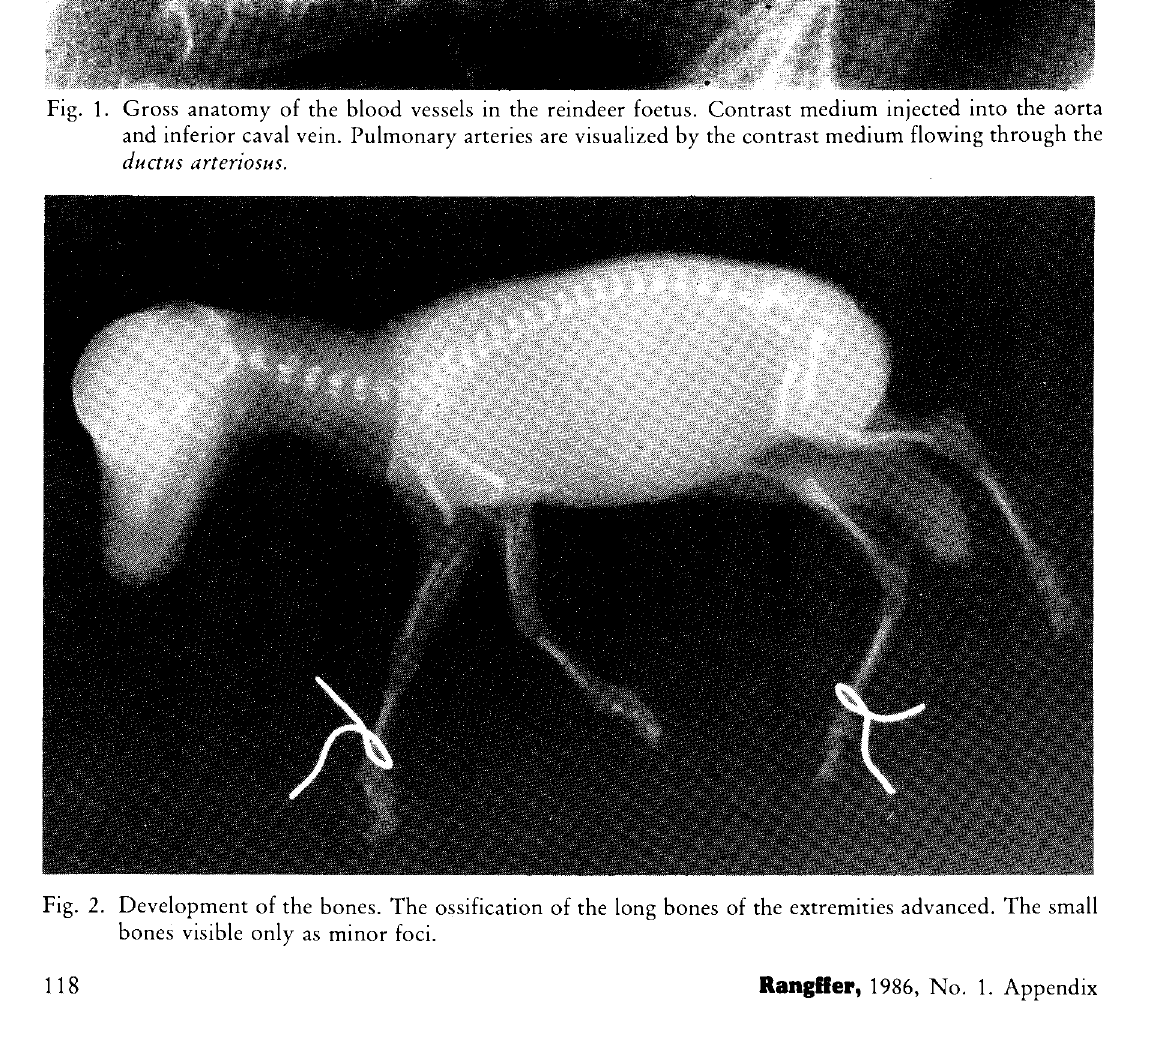
Fig. 2. Development of the bones. The ossification of the long bones of the extremities advanced. The small bones visible only as minor